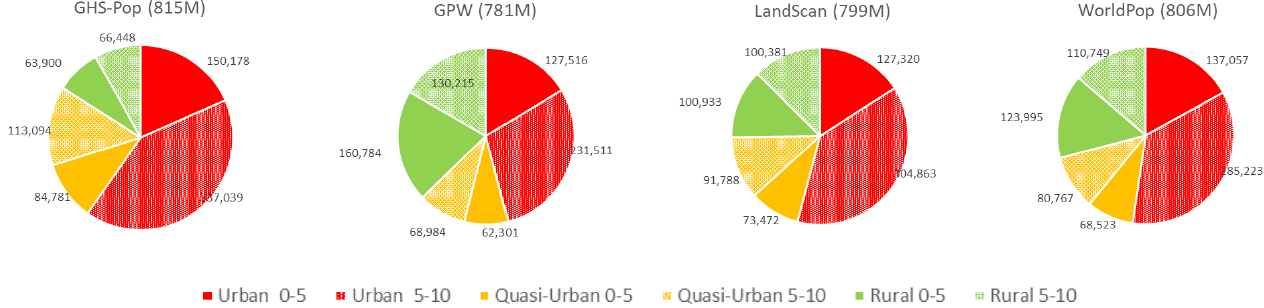
Figure 12. Proportion of the population in each urban class (urban, quasi-urban and rural) in the ≤ 5 and 5–10m LECZ, for different popu- lation data sets, 2015. Shown using GHS-SMOD as the urban proxy and MERIT DEM for LECZ delineation. Labels indicating population count (in thousands) are shown.